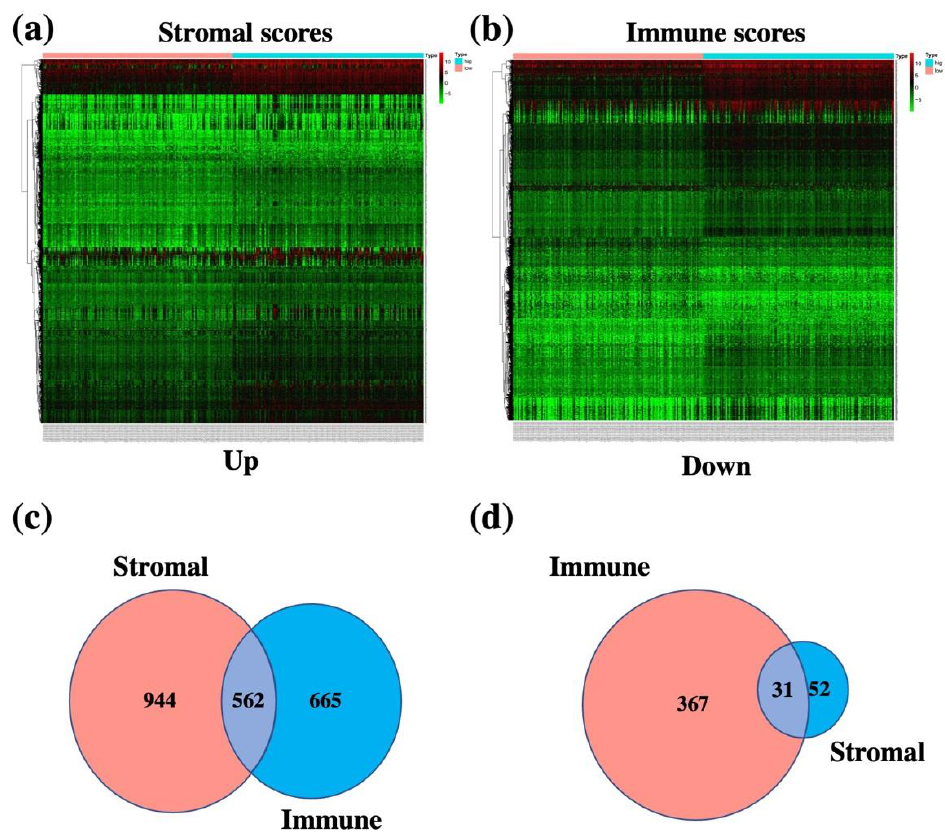
Figure 3. Venn diagram and heatmap analysis of the differentially expressed genes (DEGs) based on the immune and stromal scores. ( a ) Heatmap analysis of the DEGs between the higher stromal scores and lower stromal scores in OSCC patients. ( b ) Heatmap analysis of the DEGs between the higher immune scores and lower immune scores in OSCC patients. ( c ) Venn diagrams analysis the number of upregulated genes of higher stromal scores in OSCC patients and upregulated genes of higher immune scores in OSCC patients. ( d ) Venn diagrams analysis of the number of downregulated genes of higher stromal scores in OSCC patients and downregulated genes of higher immune scores in OSCC